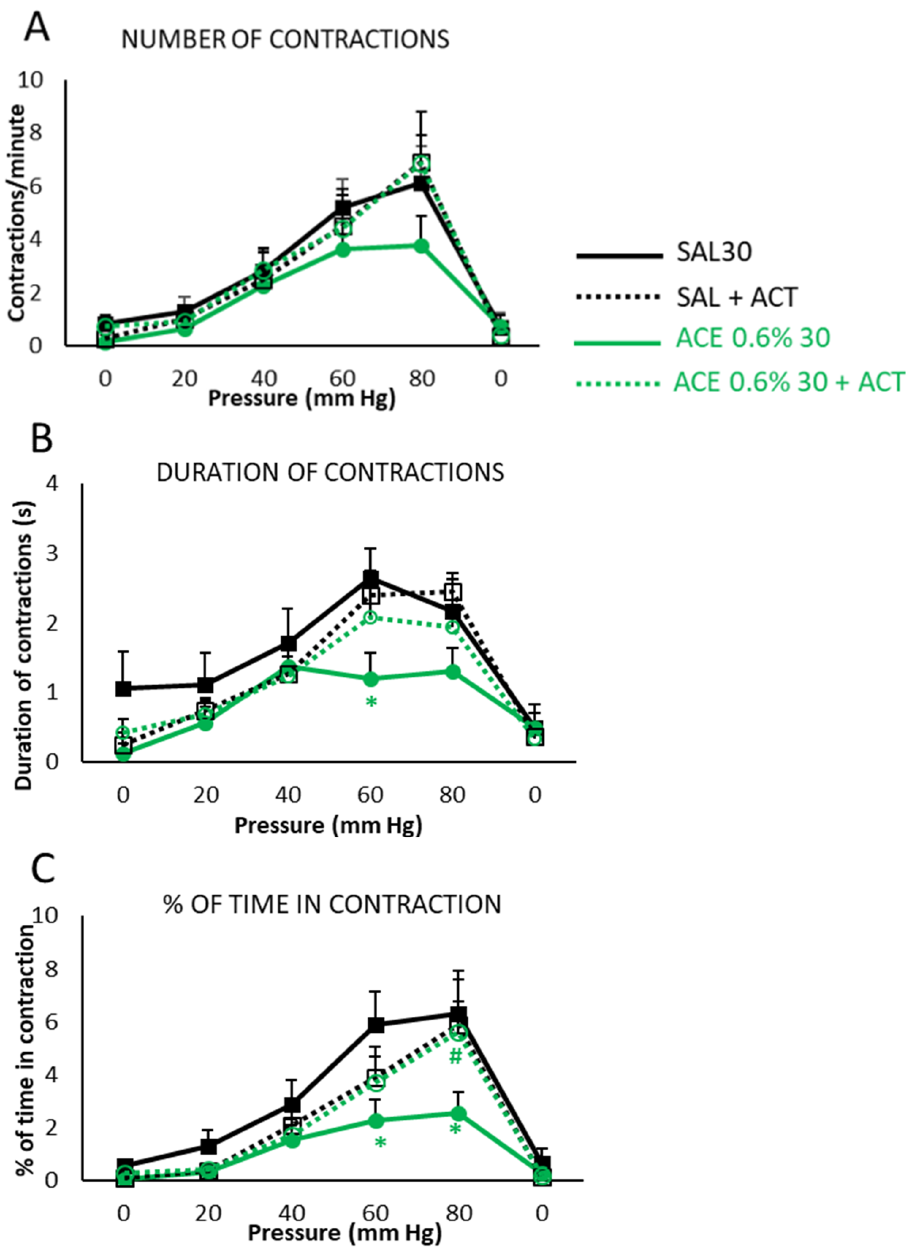
Figure 7. Effects of pretreatment with probiotics on visceral sensitivity, phase II. The groups selected in phase I (SAL30 and ACE 0.6% 30, now termed SAL, black line and ACE, green line) were compared with the corresponding two groups that were pretreated with 1 mL/day of Actimel ® (ACT) 7 days before performance of the visceral sensitivity test (SAL + ACT black dotted line, ACE + ACT green dotted line). Animals were subjected to tonic mechanical intracolonic stimulation. Pressure was increased from 0 to 80 mm Hg, in steps of 20 mm Hg every 5 min, to finally return to 0 mm Hg again; for each pressure value, a single stimulus was applied and maintained for 5 min. Number of contractions per minute ( A ), duration of contractions ( B ), and percentage of time in contraction ( C ) were measured. Data represent the mean ± SEM. * p < 0.05 vs. SAL; # p < 0.05 vs. ACE. Two-way ANOVA followed by Bonferroni post hoc test ( n = 8–10).